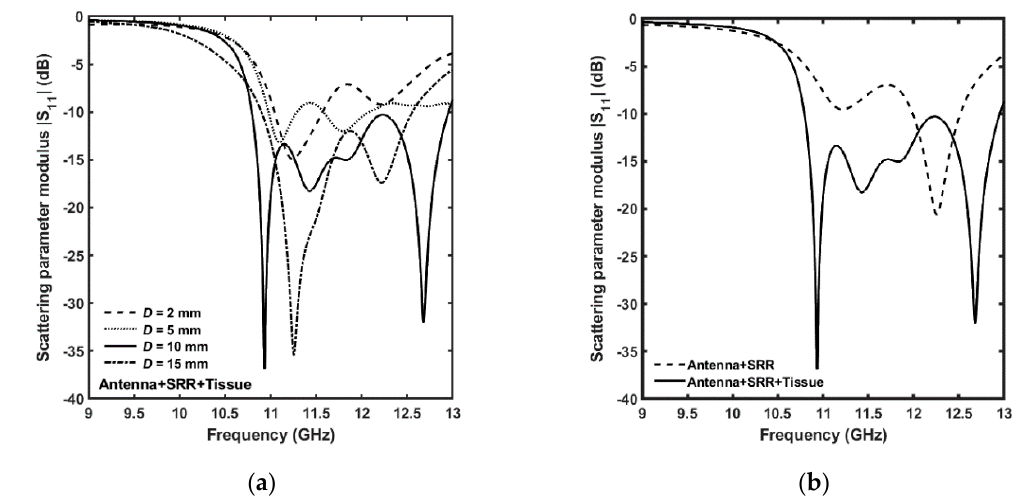
Figure 7. Simulated scattering parameter modulus | S 11 | ( a ) of the SIW cavity-backed patch antenna with SRR superstrate placed at di ff erent distances from the biological tissue and ( b ) of the SIW cavity-backed patch antenna with SRR superstrate placed at distance D = 10 mm from the human tissue (continuous line) and of the SIW cavity-backed patch antenna with SRR superstrate without tissue (dashed line).